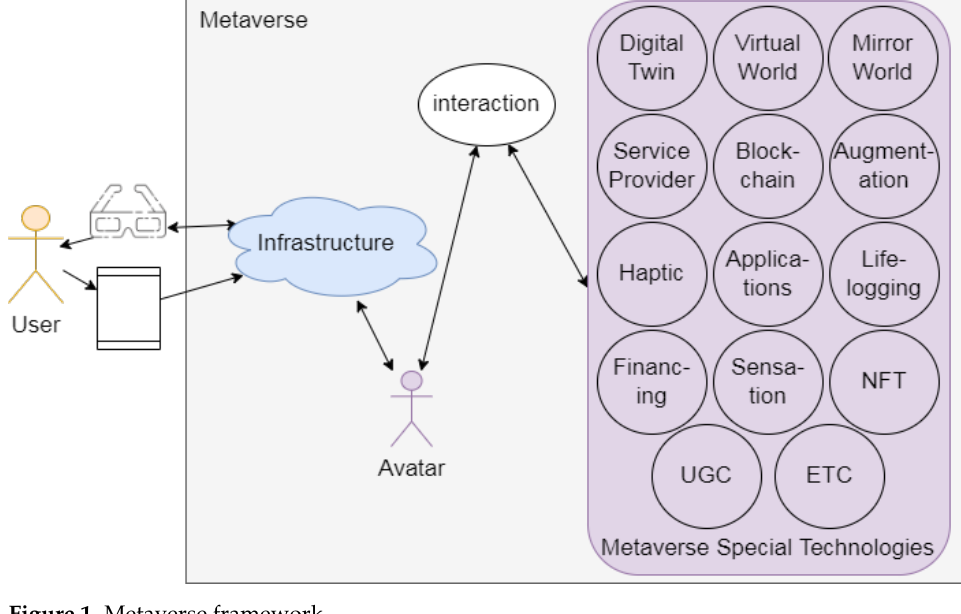
Figure 1. Metaverse framework.